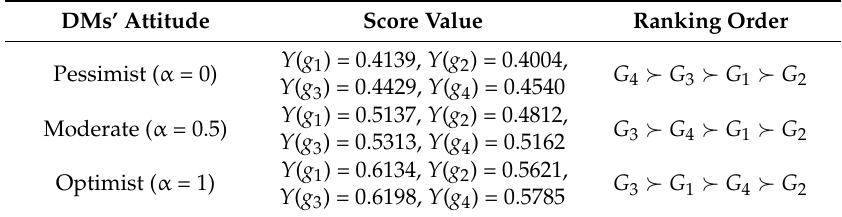
Decision results corresponding to the single-valued linguistic neutrosophic interval linguistic number weighted arithmetic averaging (SVLN-ILNWAA) operator and the decision makers’ (DMs’) attitudes.